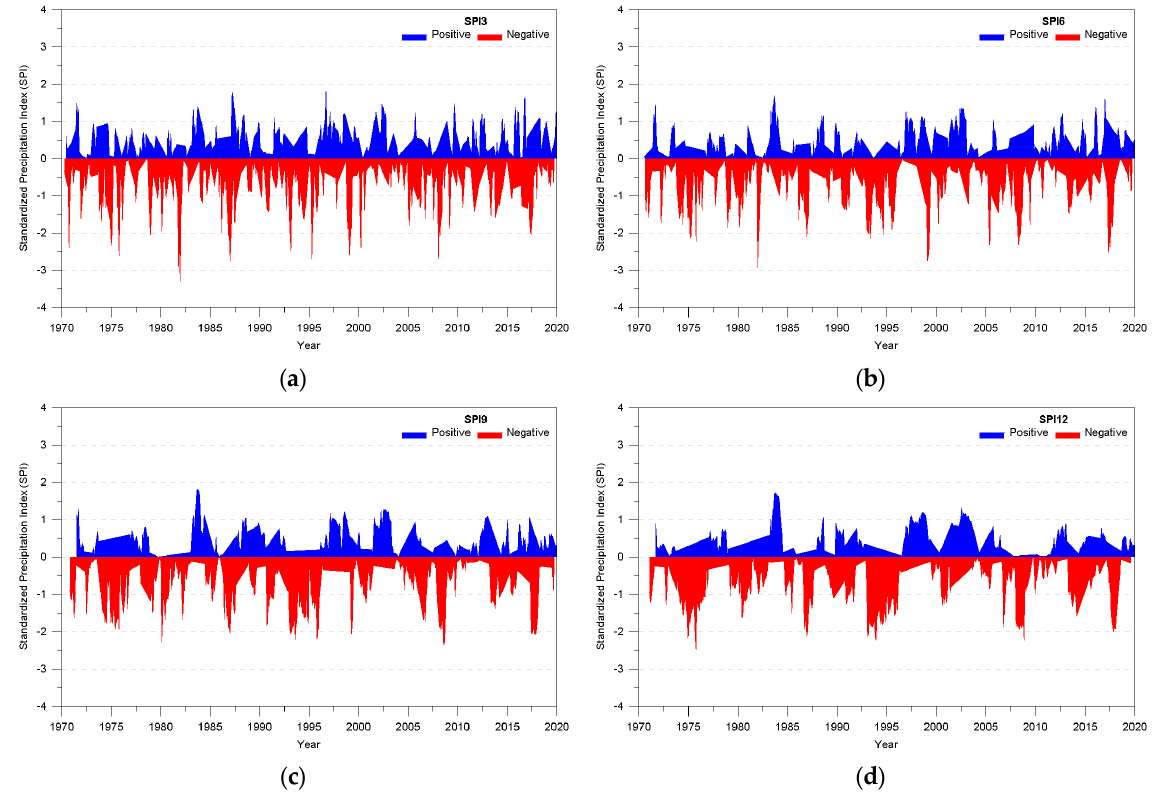
( d ) Figure 9. SPI of Gyeongsangnamdo by duration based on cluster analysis: ( a ) SPI3; ( b ) SPI6; ( c ) SPI9; ( d ) SPI12. As for the SPI of Gyeongsangnamdo by duration, the minimum value among the three clusters analyzed was set as the representative SPI by duration (Figure 10). The SPI3 of Gyeongsangnamdo ranged from − 3.30 to 1.80, and the quartiles were found to be − 0.78 for Q1, − 0.18 for Q2, and 0.44 for Q3. SPI6 ranged from − 2.94 to 1.69, and the quartiles were